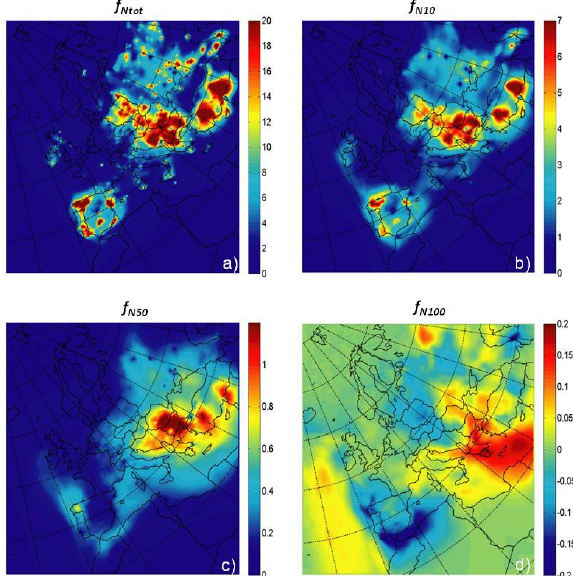
Fig. 1. Ground level average number concentrations (cm − 3 ) pre- dicted during May 2008 for (a) all particles ( N tot ) and particles Figure 1. Ground level average number concentrations (cm -3 ) predicted during May above (b) 10nm ( N 10 ) , (c) 50nm ( N 50 ) and (d) 100nm ( N 100 ) . 2008 for (a) all particles ( (cid:1) tot ) and particles above (b) 10 nm ( (cid:1) 10 ), (c) 50 nm ( (cid:1) 50 ) Different scales are used. and (d) 100 nm ( (cid:1) 100 ). Different scales are used.